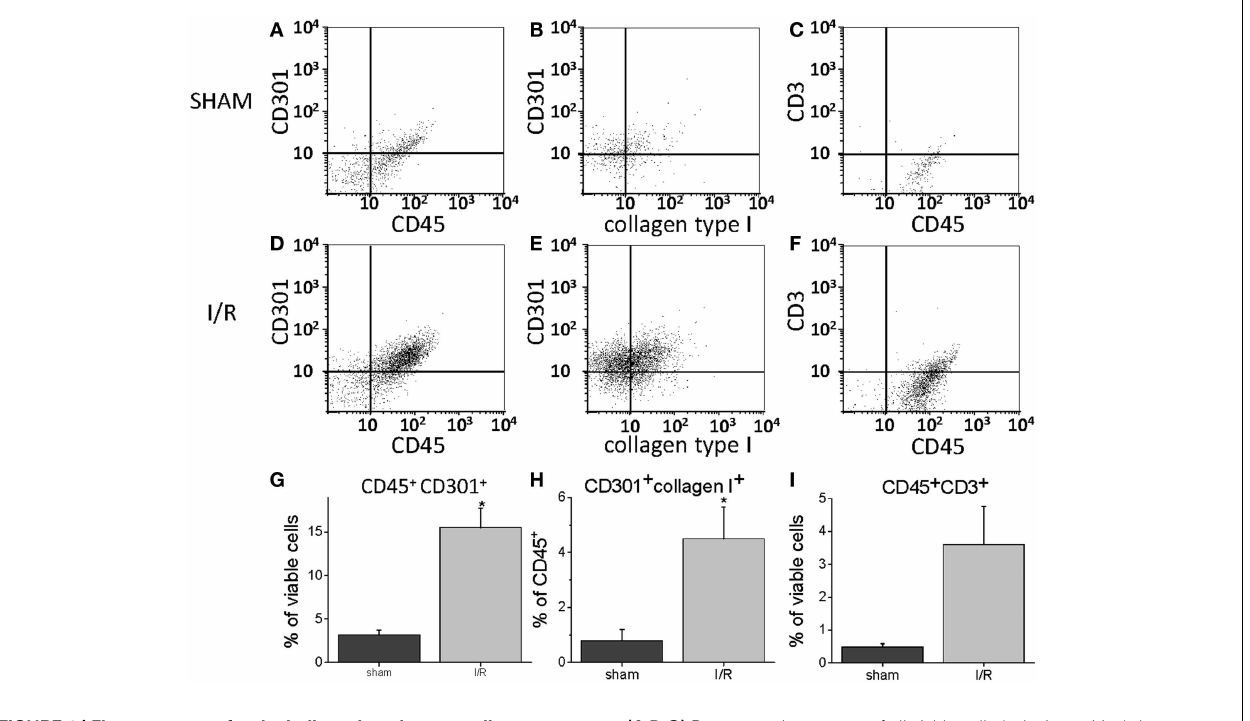
FIGURE 1 | Flow cytometry for the indicated markers on cells harvested from mouse hearts after 5days of I/R or from sham-treated animals . (A) Through (C) are representative histograms for sham-treated animals. (D) Through (F) are representative histograms for I/R animals. (G) Through (I) are summary data